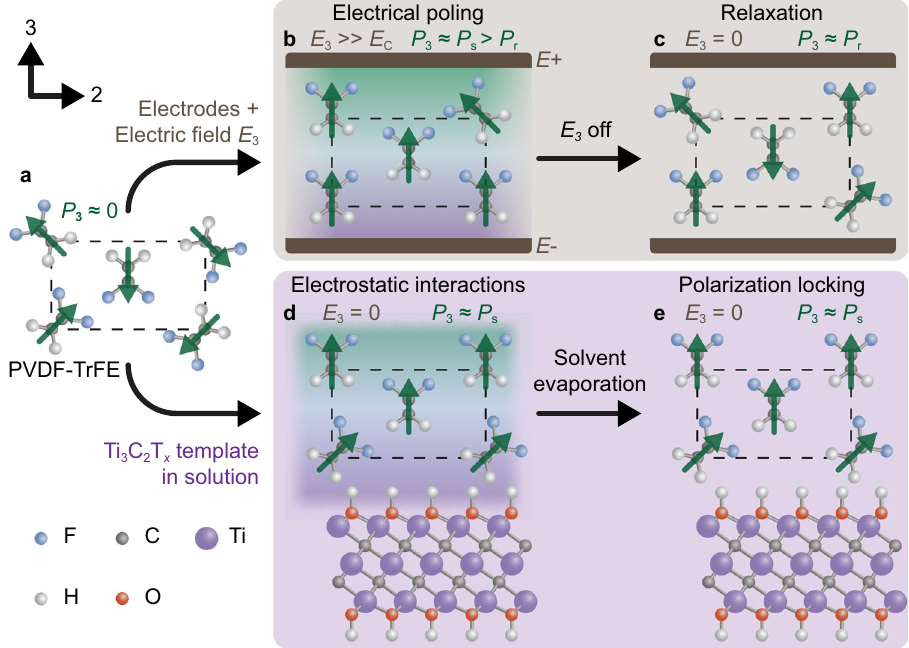
Fig. 1 Simpli fi ed schematic outlining the nanomaterial-induced polarization locking mechanism in PVDF-TrFE as an alternative to the conventional electrical poling method. a The β phase PVDF-TrFE chains, obtained directly following fi lm deposition, exhibit a randomized dipolar orientation (green arrows), resulting in a negligible net polarization ( P ). b In the electrical poling method, electrodes are attached to the surfaces perpendicular to the desired polarization direction and an electric fi eld ( E ) is applied, signi fi cantly higher than the coercive fi eld ( E C ) in order to orient the individual dipole moment vectors and maximize the P to the spontaneous polarization ( P s ). c Following the removal of the E , the PVDF-TrFE chains undergo partial relaxation from P s to the remnant polarization ( P r ). d Conversely, adding the Ti 3 C 2 T x (T x ≈ OH) nanosheets to the PVDF-TrFE in the solution enables the P to align, without an applied electric fi eld, perpendicular to the basal plane of the Ti 3 C 2 T x nanosheets via electrostatic interactions at the interface. e Following deposition,